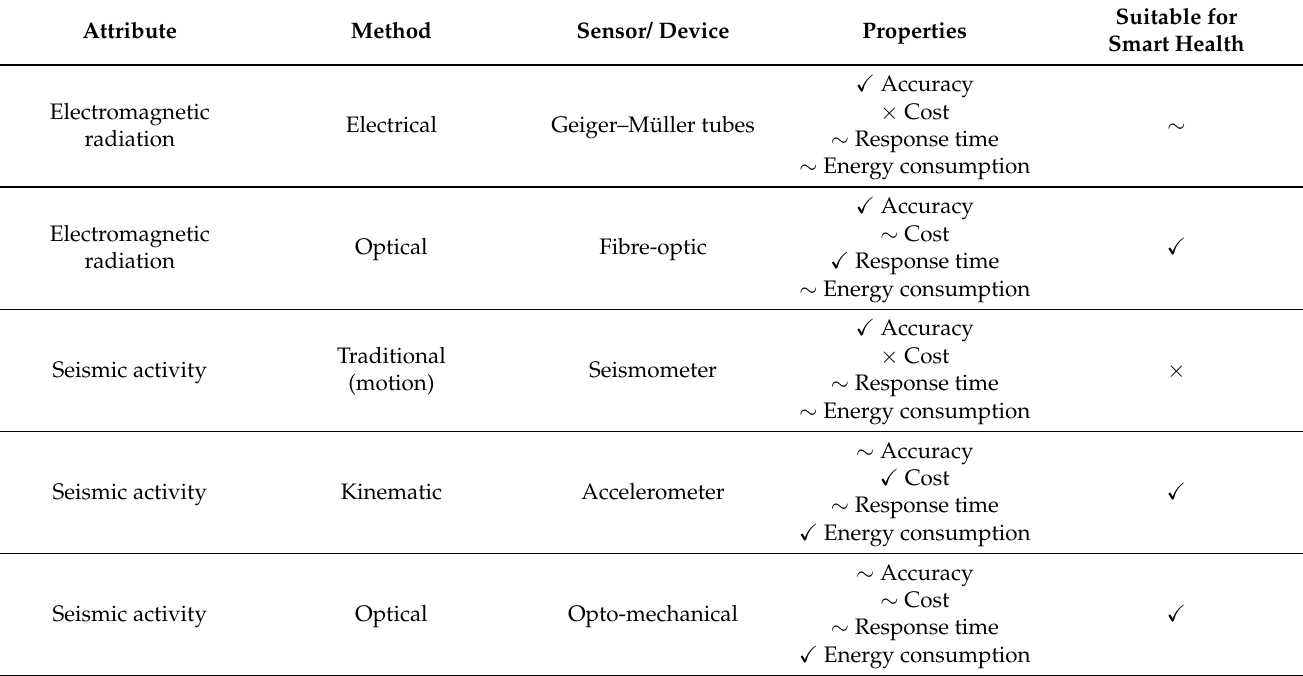
Table 10. Characteristics of the methods for electromagnetic radiation sensing and seismic activity sensing. Attribute Method Sensor/ Device Properties